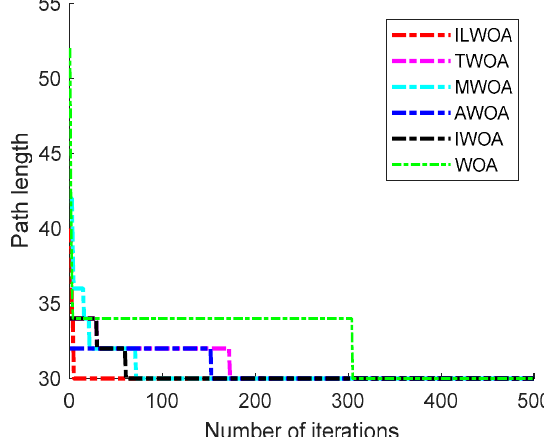
Figure 10. Optimal iteration curve.